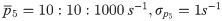
Exploring the parameter space for three different PAC combinations.A) Average cTE values for delta-gamma (orange), theta-gamma (green), and alpha-gamma (blue) PAC when considered 100 different values for nine different parameters: 1) a multiplying factor η = 0.03:0.03:3 controlling the global strength of the connectivity matrix (Γnm = ηΓnm), 2) the reciprocal of the time constant of RS populations (kRS = 5:5:500s−1), 3) the reciprocal of the time constant of IB populations (kIB = 5:5:500s−1), 4) the reciprocal of the time constant of LTS populations (kLTS = 5:5:500s−1), 5) the reciprocal of the time constant of FS populations (kFS = 5:5:500s−1), 6) the external input to the L4RS population (p¯5=10:10:1000s−1,σp5=1s−1), 7) the external input to the L4FS population (p¯7=10:10:1000s−1,σp7=1s−1), 8) the gains of the six excitatory populations (GE ≡ G1 = G2 = G5 = G8 = G9 = G12 = 0.2:0.2:20mV), and 9) the gains of the eight inhibitory populations (GI ≡ G3 = G4 = G6 = G7 = G10 = G11 = G13 = G14 = 0.5:0.5:50mV). B) Plot of cTE versus η. C) Average cTE values for direct and indirect PAC connections. Labels ‘d’, and ‘i’ correspond to direct and indirect PAC connections.